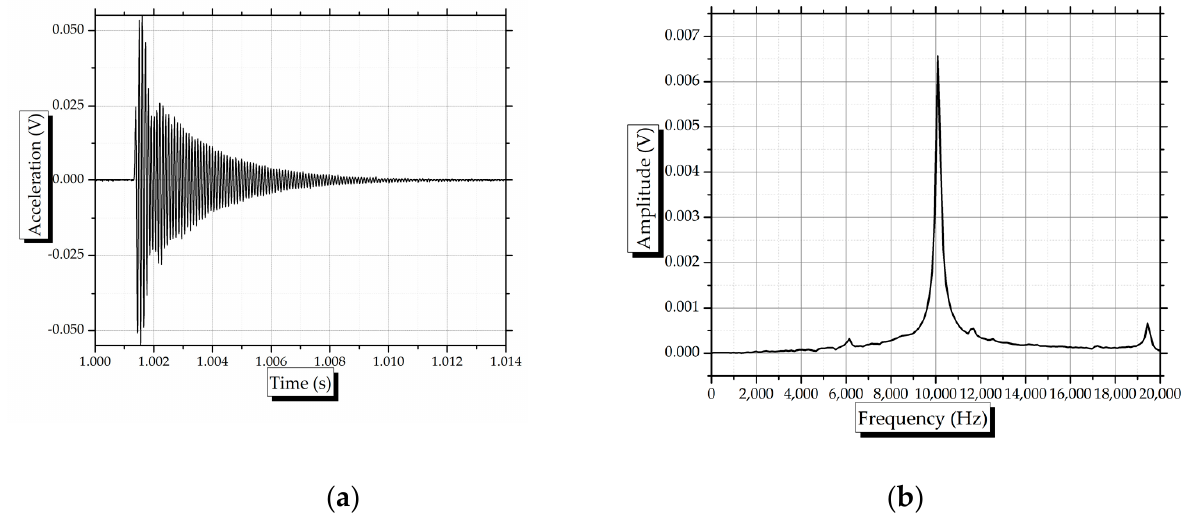
Figure 7. Assessment of the fundamental frequency of vibration. ( a ) Damped free vibrations; ( b ) Response spectrum (FFT).